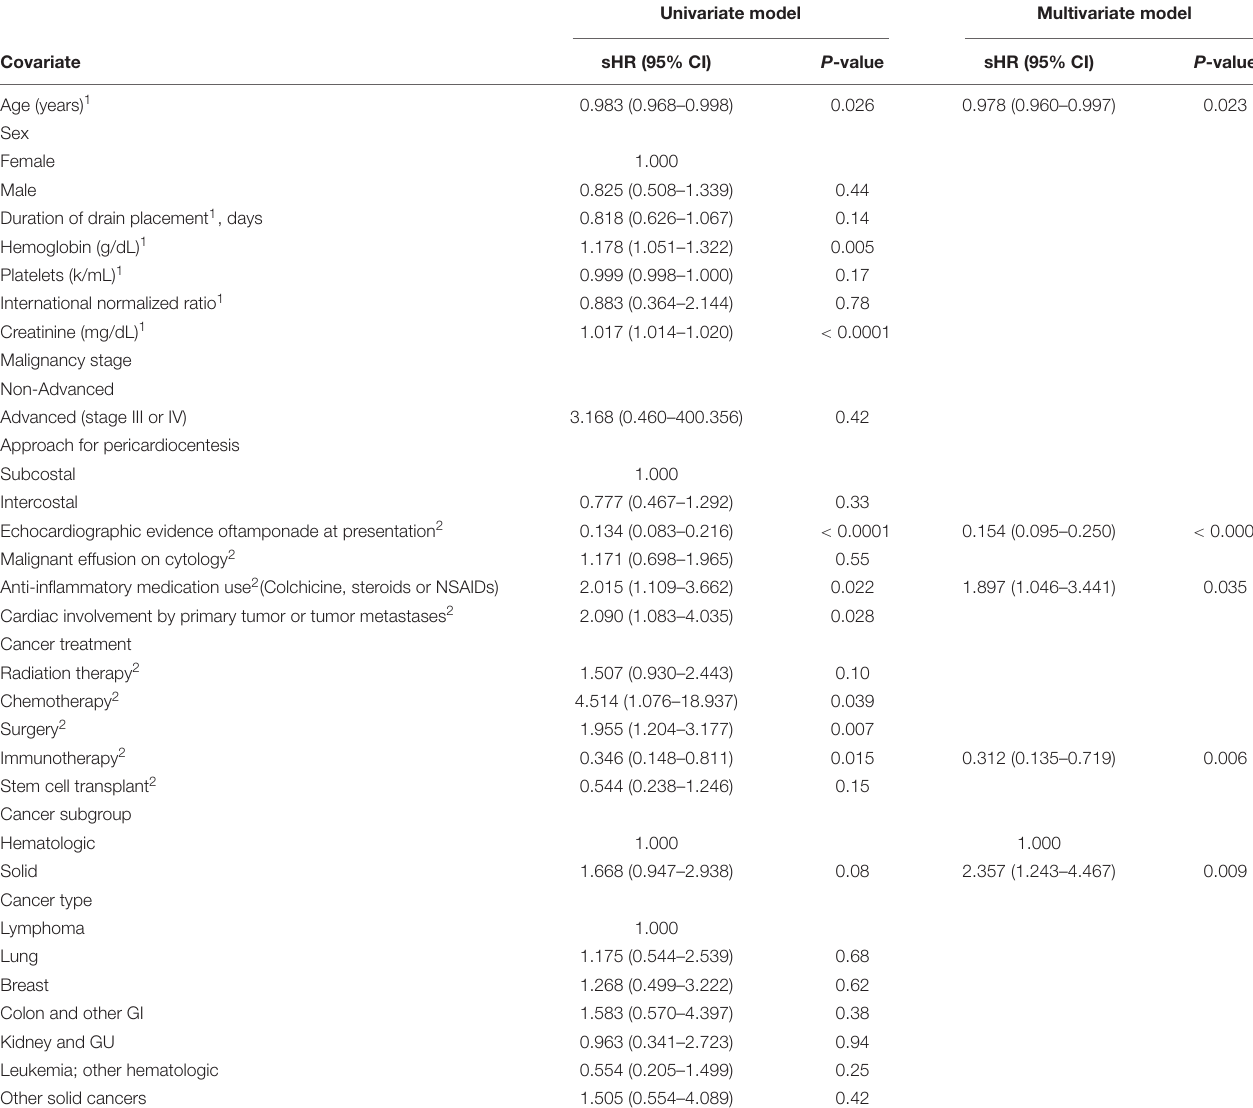
Univariate model Multivariate